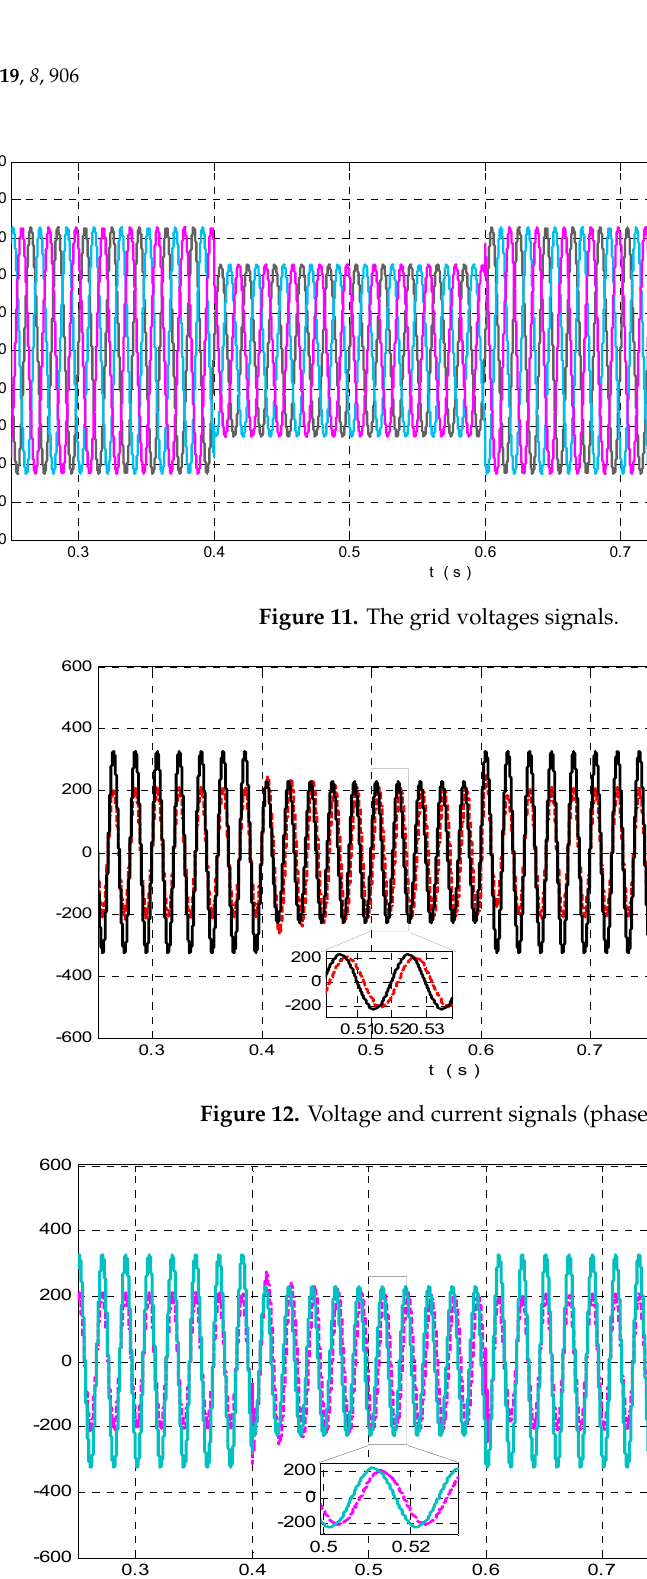
Figure 9. The active and reactive power fed to the grid .